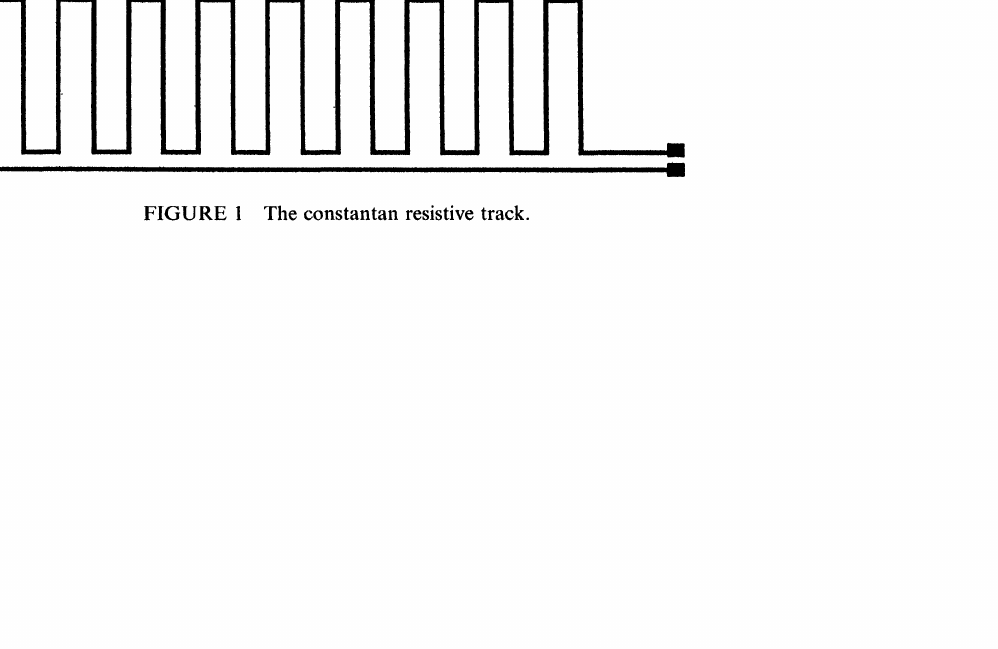
FIGURE The constantan resistive